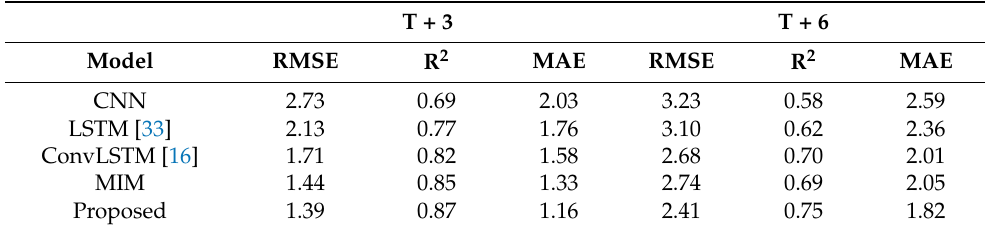
Table 4. Multi-step duration prediction